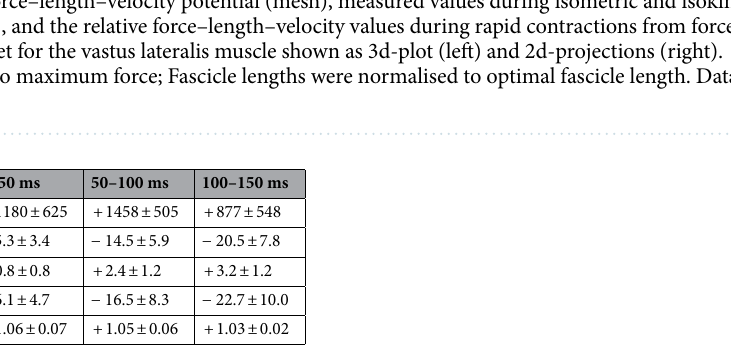
Table 1. Changes in force, fascicle length, pennation angle and muscle length in 50 ms time intervals after torque